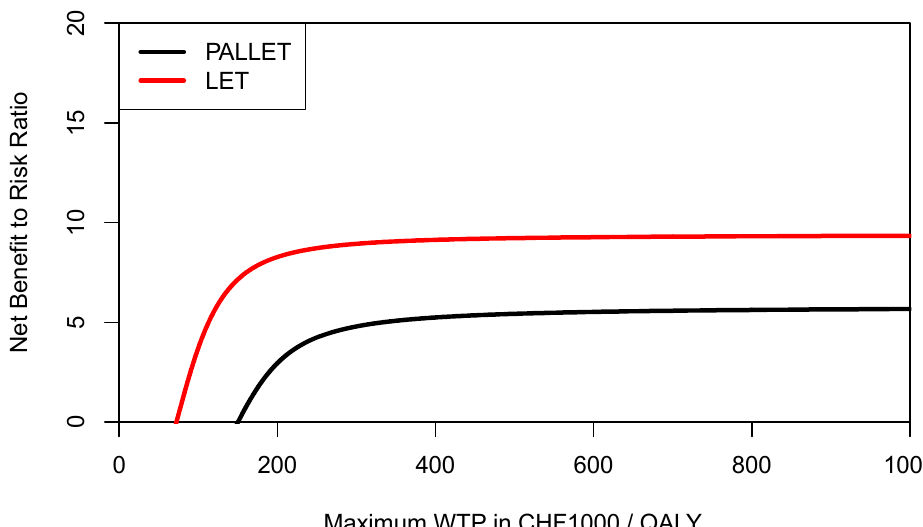
Figure 7. Cost-effectiveness risk-aversion curve (CERAC) of PALLET (palbociclib and letrozole)